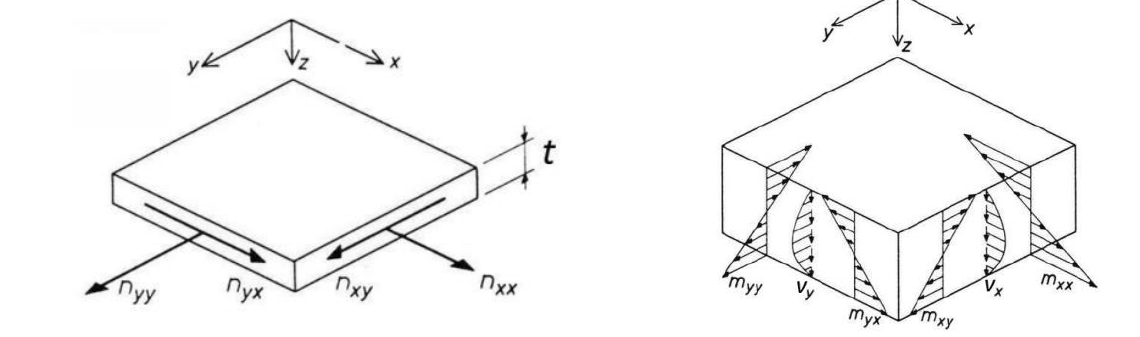
Fig. 4 stress distribution in plates under out-of-plane loads (Borgart 2016).